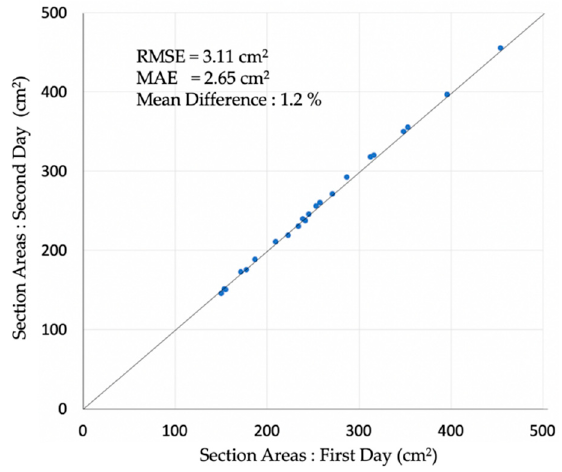
Figure 20. Estimation of section areas.